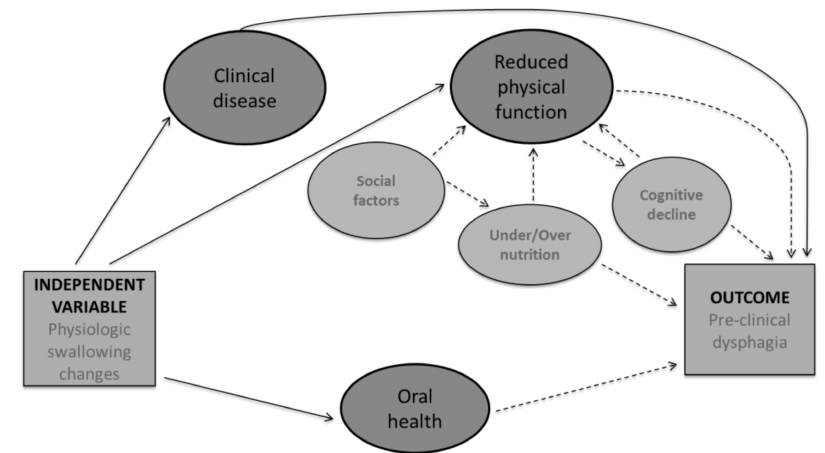
Figure 1. Proposed conceptual framework for the development of pre-clinical dysphagia in the CDOA. Proposed theoretical model for the development of pre-clinical dysphagia in CDOA. Solid lines represent known causes while dashed lines represent reported